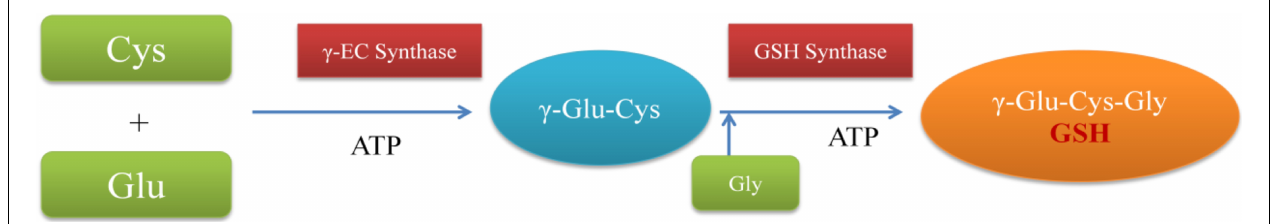
FIGURE 2 | Schematic representation of GSH biosynthesis. Cys, L-cysteine; Glu, L-glutamate; γ -Glu-Cys, γ -glutamylcysteine ; γ -EC synthase, γ -glutamylcysteine synthase.